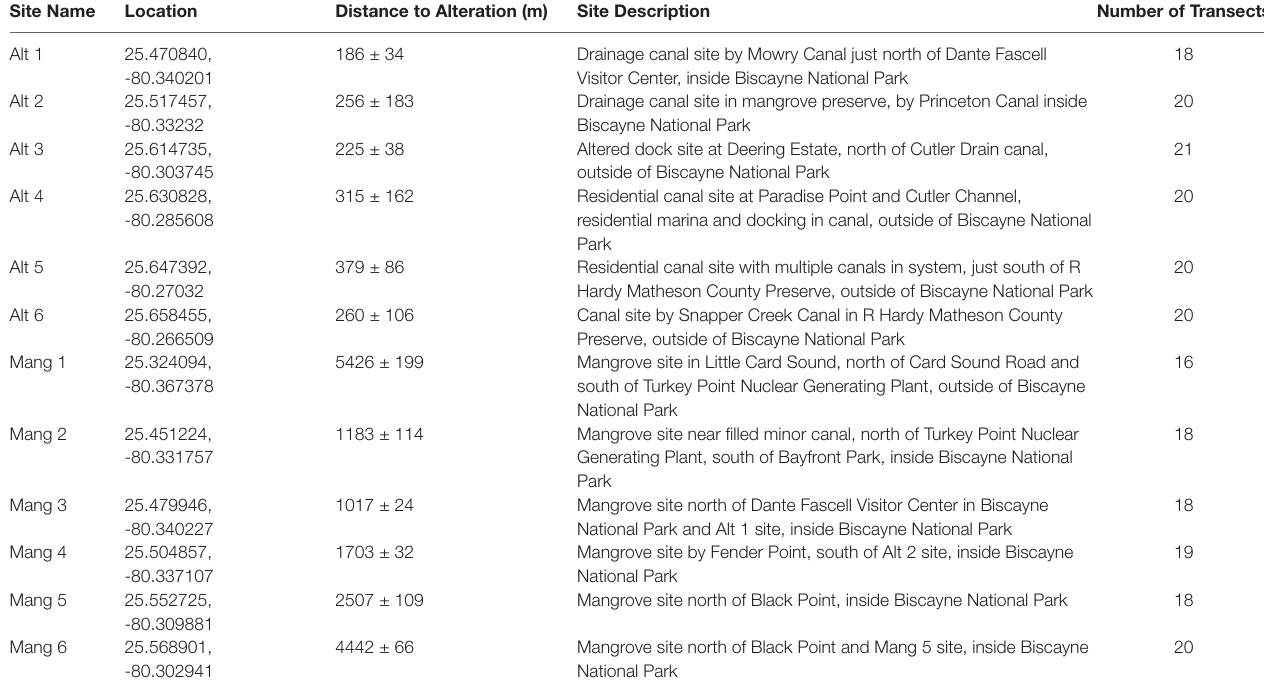
TABLE 1 | The location, description, and sampling effort for each survey